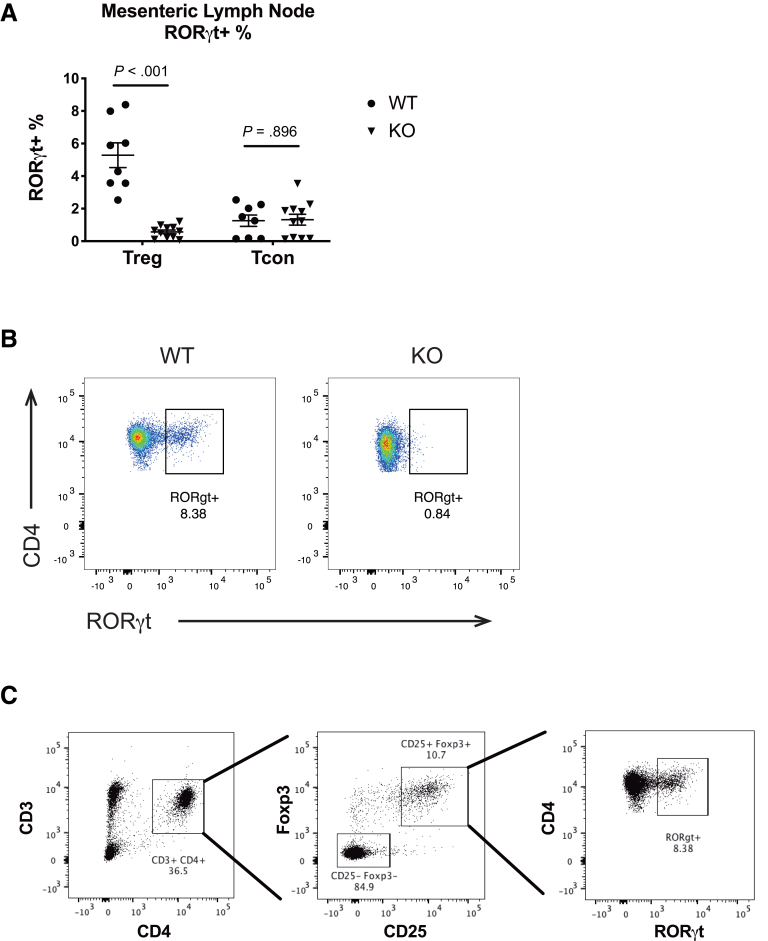
Mettl14-deficient Treg cells have decreased RORγt expression. (A) RORγt percentage in the mesenteric lymph nodes of Treg and conventional T cells. (B) Representative flow cytometry image showing decreased RORγt expression in Treg cells. The cells were gated from a parent population of CD25+Foxp3+ cells. (C) Gating strategy of flow cytometry analysis of RORγt+ cells. WT indicates wild-type littermate control. KO indicates CD4-Cre+/TgMettl14FL/FL conditional knockout. Data are represented as mean ± SD; n = 8–11 mice per group. Combined data from 3 independent experiments shown.